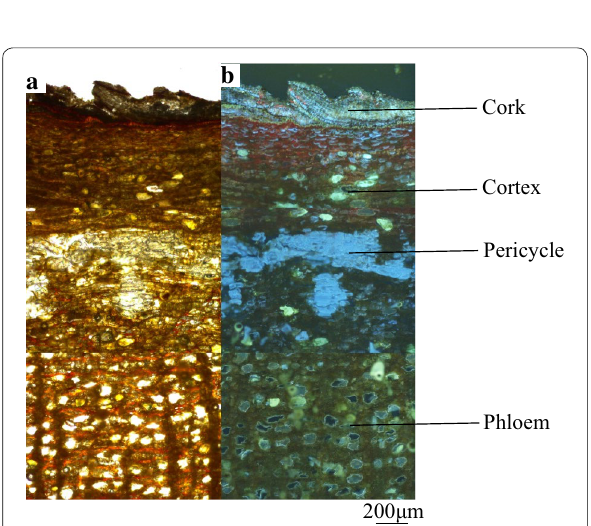
Fig. 2 Microscopic characteristics of the Cinnamomum cassia (RGyueaj). a Observed under the light microscopy. b Observed under the fluorescent